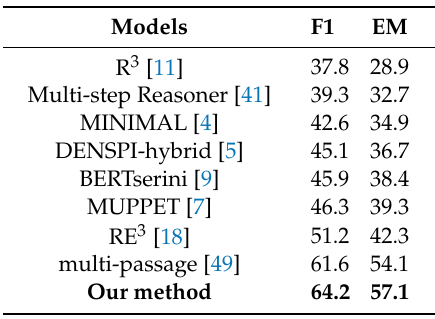
Table 2. SQuAD results: We report the F1 and EM scores on SQuAD, following previous work. The highest value per column is marked in